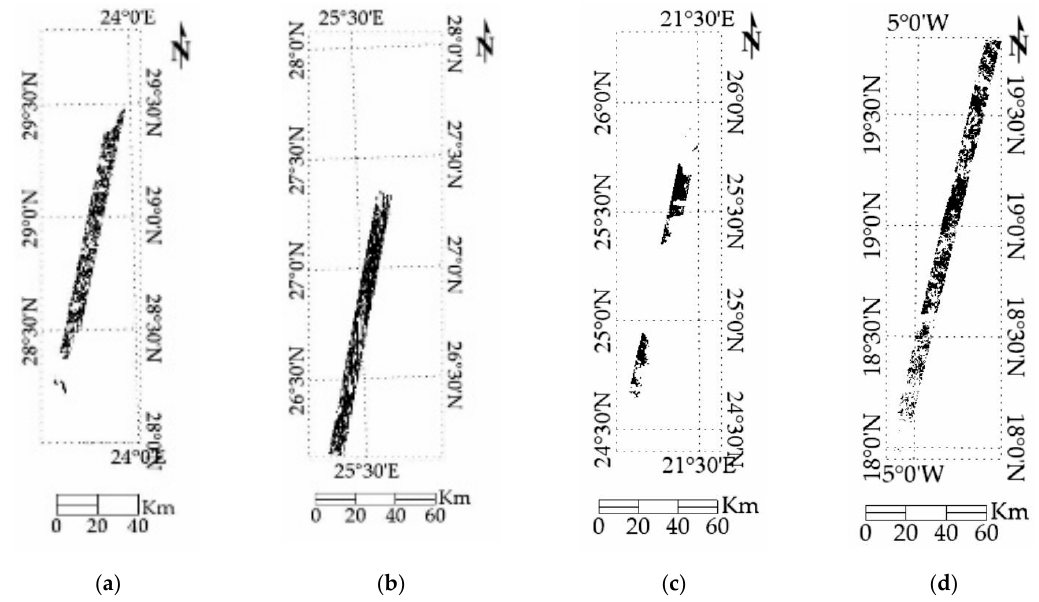
Figure 6. Cluster 13 Binary Masks: ( a ) Path/ Row 181/40 (Libya 4), ( b ) Path/ Row 179/41 (Egypt 1) ( c ) Path/ Row 182/42 ( d ) Path/Row 198/47. Black pixels represent Cluster 13 pixels from the Hyperion images.